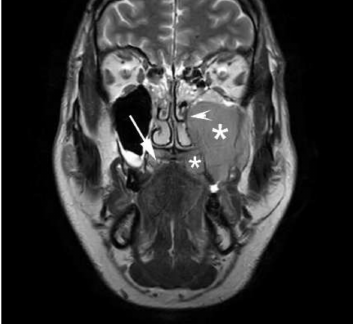
Figure 5. Coronal T2 weighted magnetic resonance imaging of the lesion involving hard palate and the left maxillary sinus. The * sign indicates the tumor mass. White arrow shows the intact part of hard palate on the right side. White arrowhead marks the dislocation of the medial wall of the left maxillary